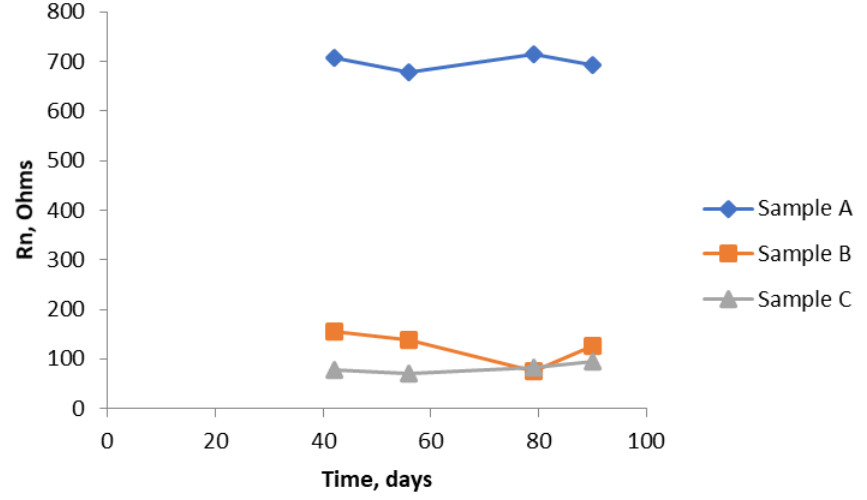
Figure 12. Comparison of R n from all three samples (A, B, and C) with the bridge arrangement.